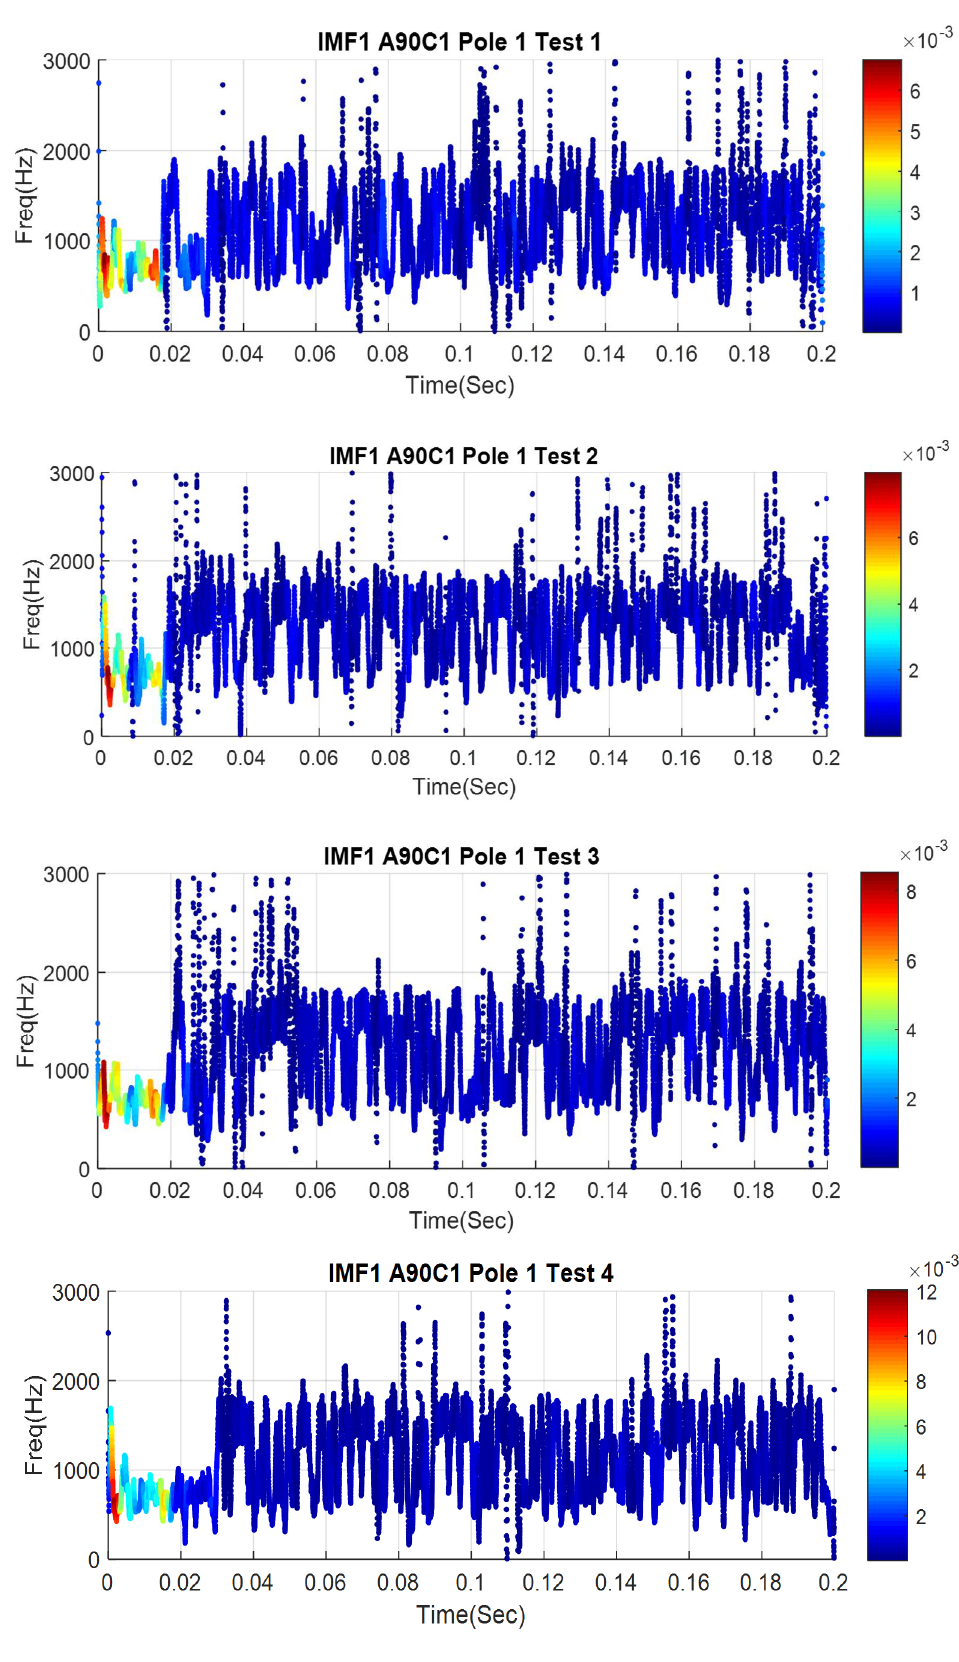
Figure 17. Hilbert spectrum of IMF1 for A90C1, Serviceable Pole 1 including all 4 tests. Additional significant finding here is that the improved HHT is able to recover low frequency and low energy components. Considering the signal up to 0.02 sec in Figure 16, it is observed that instantaneous frequency of IMF5 is almost constant at 55 Hz. This is the possible fundamental frequency/natural frequency of that particular pole. Similarly, 105 Hz and 250 Hz frequencies are observed for IMF4 and IMF3, respectively, which are be- lieved to be higher order fundamental frequencies. Since the condition of this pole is be- lieved to be healthy, there are not much sudden changes in the instantaneous frequency of IMF3, IMF4, and IMF5 and very slight changes are observed for IMF2. Similar analysis has been performed for 12 accelerometer data of 3 serviceable poles and 3 unserviceable poles obtained from all 4 tests in order to check the repeatability and consistency of the results. After that, frequency range of dominant IMFs, average frequency of each domi- nant IMF and standard deviation are calculated. Figures 18 and 19 demonstrate the fre- quency range of dominant IMFs, average frequency of each dominant IMF and standard deviation for Serviceable Pole 1 and Unserviceable Pole 3, respectively, considering all the accelerometer data. Both the poles are from same species and their strength class and du- rability class are also same. Frequency range of dominant IMFs for Serviceable Pole 1 are found to be in a similar range with good consistency considering the variability and un- certainty can exist in any field testing (Figure 18). On the other hand, frequency ranges of dominant IMFs for the Unserviceable Pole 3 (from Figure 19) are found to be bigger than that of the serviceable pole case. Standard deviation values are also relatively high for the Unserviceable Pole 3.